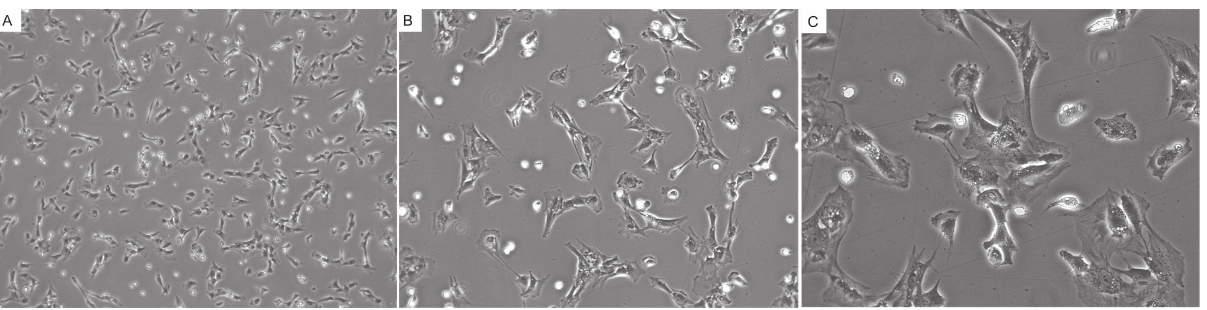
Figure 2- Primer sequences and conditions used for reverse transcriptase-polymerase chain reaction (RT-PCR)